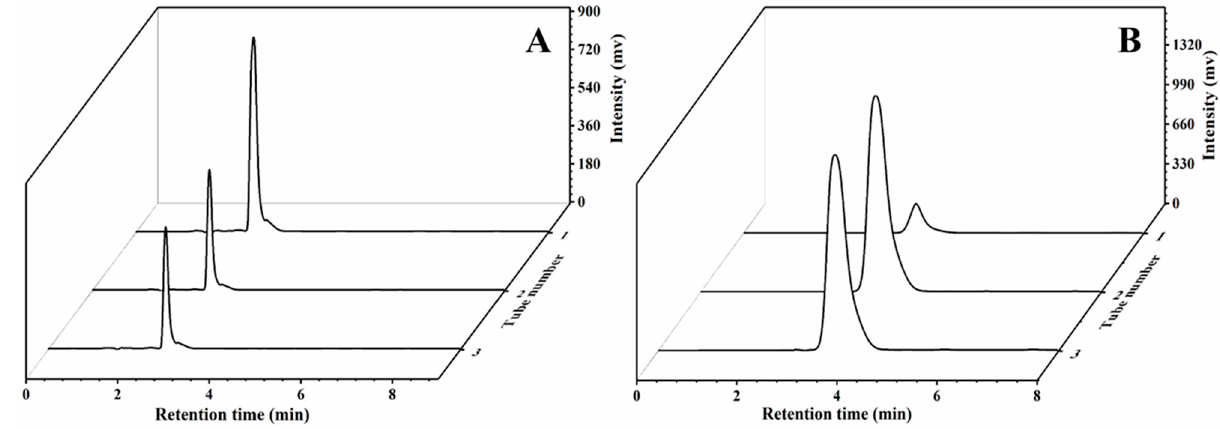
Figure 8. HPLC chromatograms of the collected samples from menadione and squalene simulation system by RP-C18 chromatography: ( A ) MCC-g-LMA effect of the flocculant on menadione; ( B ) MCC-g-LMA effect of the flocculant squalene.